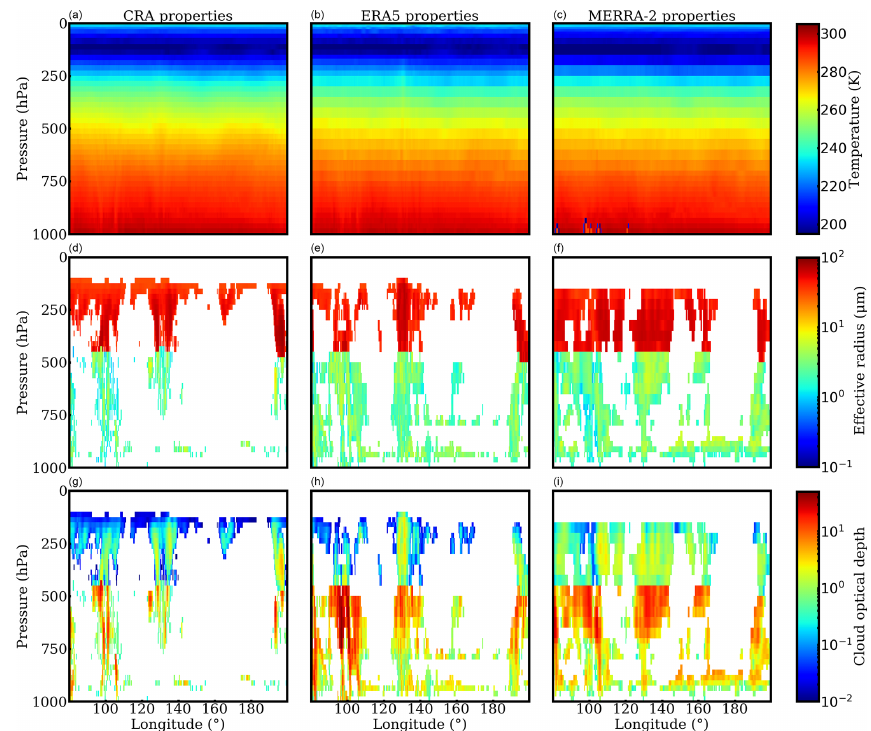
Figure 7. Comparison of the profiles of temperature, cloud effective radius, and optical depth in CRA (a, d, g) , ERA5 (b, e, h) , and MERRA- 2 (c, f, i) reanalysis datasets. The profiles are for the track marked by a solid blue line in Fig. 3.